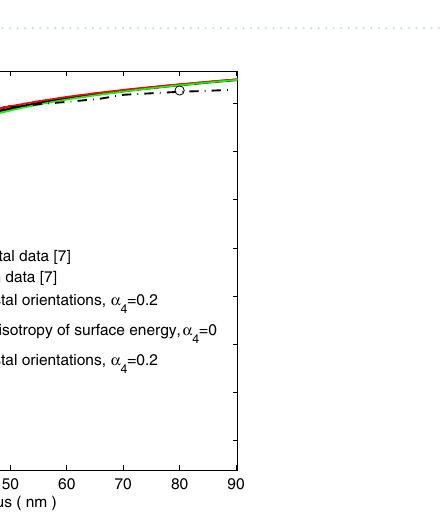
Figure 1. Size dependence of the melting temperature profile for indium nanoparticles. The black circles and black dotted line are the experimental data of a ball-milled sample and simulation data made by Lu and Jin 7 , respectively. The black solid line and red solid line denote respectively the melting temperatures with surface energy and without surface energy, plotted with the asymptotic solution (17). By contrast, the black dashed line denotes the bulk melting point.